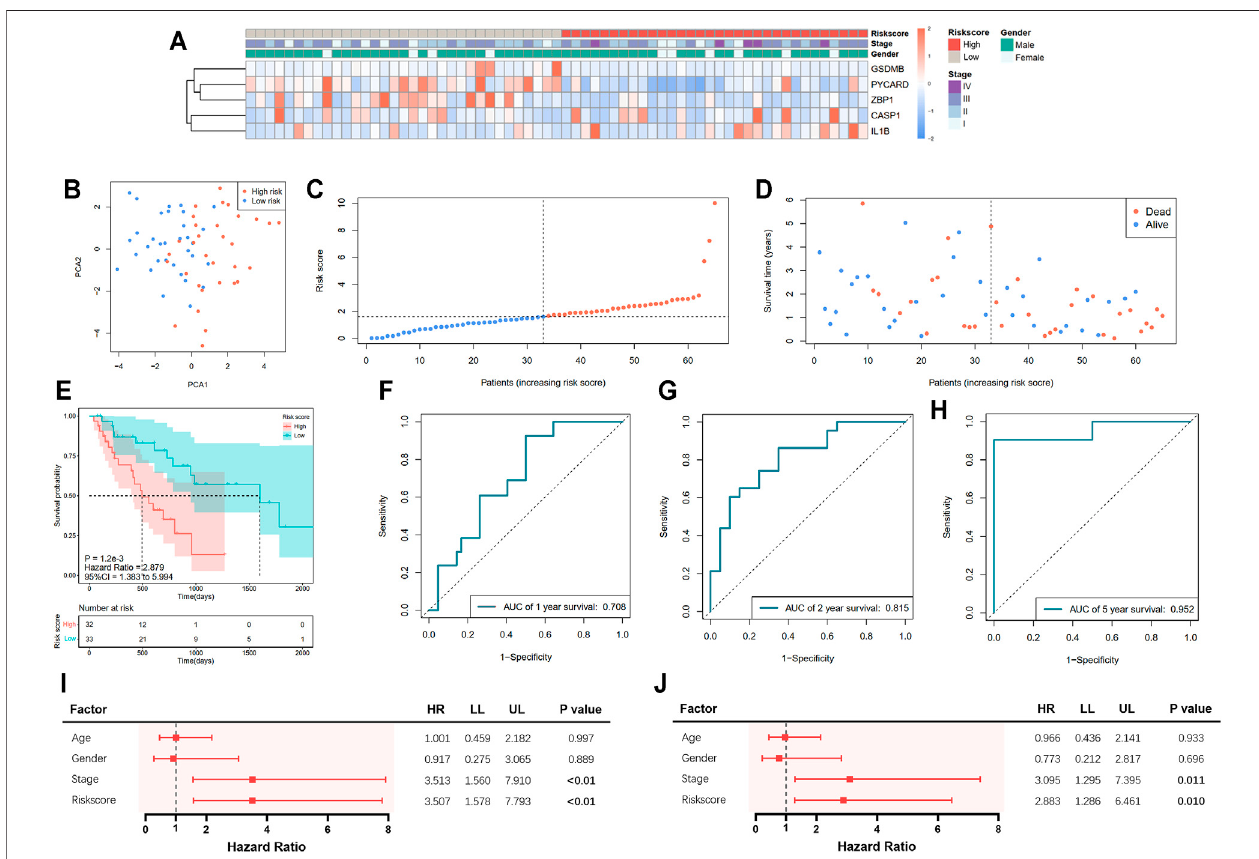
FIGURE3| Predictionofprognosisusingthepyroptosis-related fi ve-genesignatureintheTCGAcohort. (A) Heatmapof fi veselectedgeneexpressionswithclinical features ordered by risk score (red: higher expression; blue: lower expression). (B) Principal component analysis (PCA) of the risk groups. (C) Distribution of patients according to risk scores. (D) Survival time and status of patients. (E) Kaplan – Meier curves for the survival of patients in the low- and high-risk groups. (F – H) Receiver operating characteristic (ROC) curve for 1-, 2-, and 5-year survival of patients. (I) Univariate Cox analysis. (J) Multivariate Cox analysis.